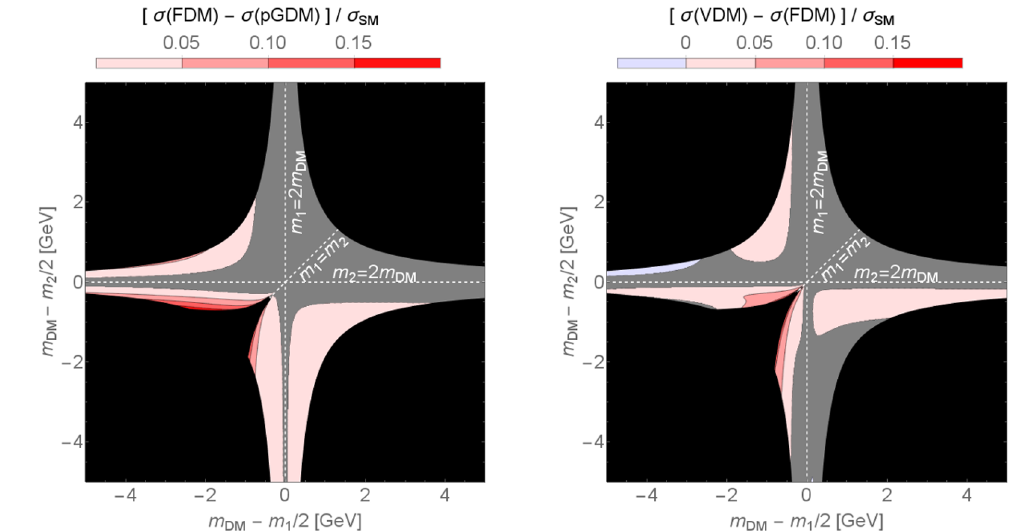
Figure 13 . The di(cid:11)erence between predictions for the pGDM and the FDM (left panel), and the FDM and the VDM (right panel). The gray region denotes parameter space for which the di(cid:11)erence is smaller than the limit of (cid:12)gure 8. The models are compared in the region where both of them are consistent with the data, see (cid:12)gure 11.